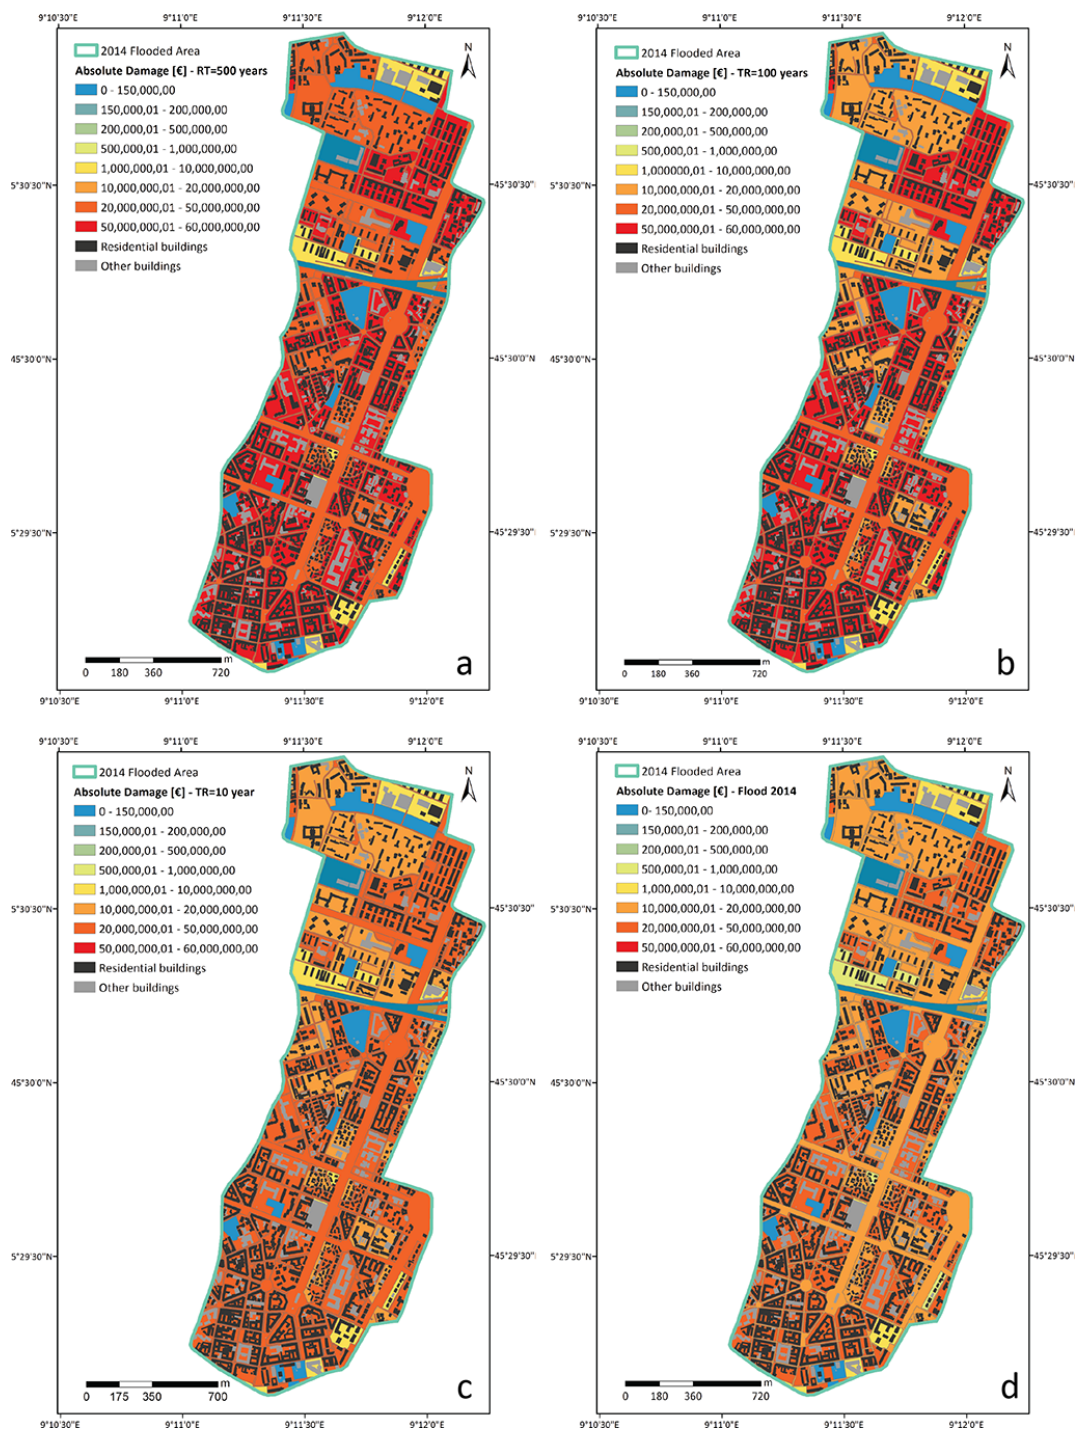
Figure 11. Mesoscale absolute damage mapping considering return periods of (a) 500, (b) 100 and (c) 10 years and (d) the 2014 flood event for Urban Atlas 2018 land-use classes. Built-up-area shapefile is from © OpenStreetMap contributors 2022. Distributed under the Open Data Commons Open Database License (ODbL) v1.0. Base maps are from © European Union, Copernicus Land Monitoring Service 2022, European Environment Agency